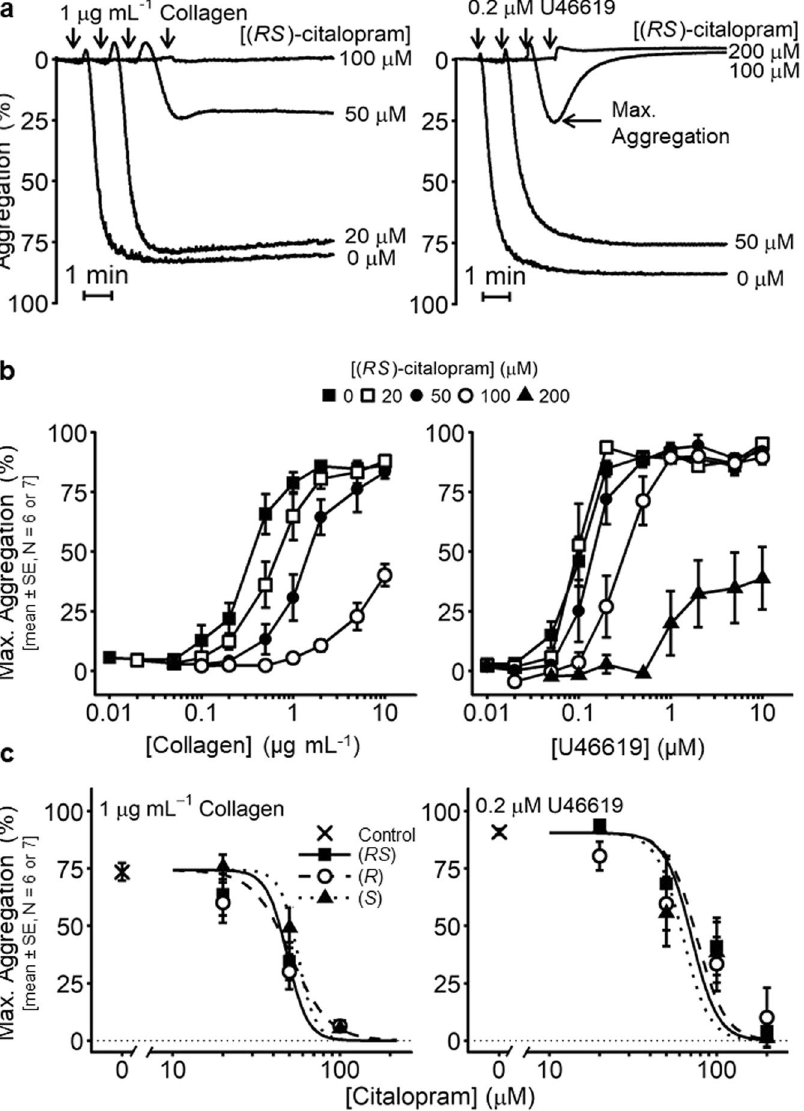
Figure 1. Inhibition by citalopram of platelet aggregation induced by Horm collagen (N = 7 blood donors) and U46619 (N = 6 blood donors). ( a ) Example aggregation traces, illustrating concentration-dependent inhibition of collagen- and U46619-induced platelet aggregation by ( RS )-citalopram. Arrowheads indicate the addition of agonist. ( b ) Collagen and U46619 concentration-response curves showing inhibition by ( RS )-citalopram of the maximum extent of aggregation. ( c ) ( RS )-, ( R )- and ( S )-citalopram inhibited the maximum extent of aggregation induced by 1 µ g mL − 1 collagen or 0.2 µ M U46619 with similar inhibitory potencies ( pIC 50 ). 3-way ANOVA was performed with IBM SPSS v.23 (Effect 1 (fixed) = citalopram preparation {( RS ), ( R ), ( S )}; Effect 2 (fixed) = agonist {collagen, U46619}; Effect 3 (random) = donor {N = 7 (collagen), N = 6 (U46619)}). The results indicated no difference in the pIC 50 of the three citalopram preparations ( P = 0.95, F = 0.054, degrees of freedom (df) = 2, 27. H H 1 : μ collagen ≠ μ U46619